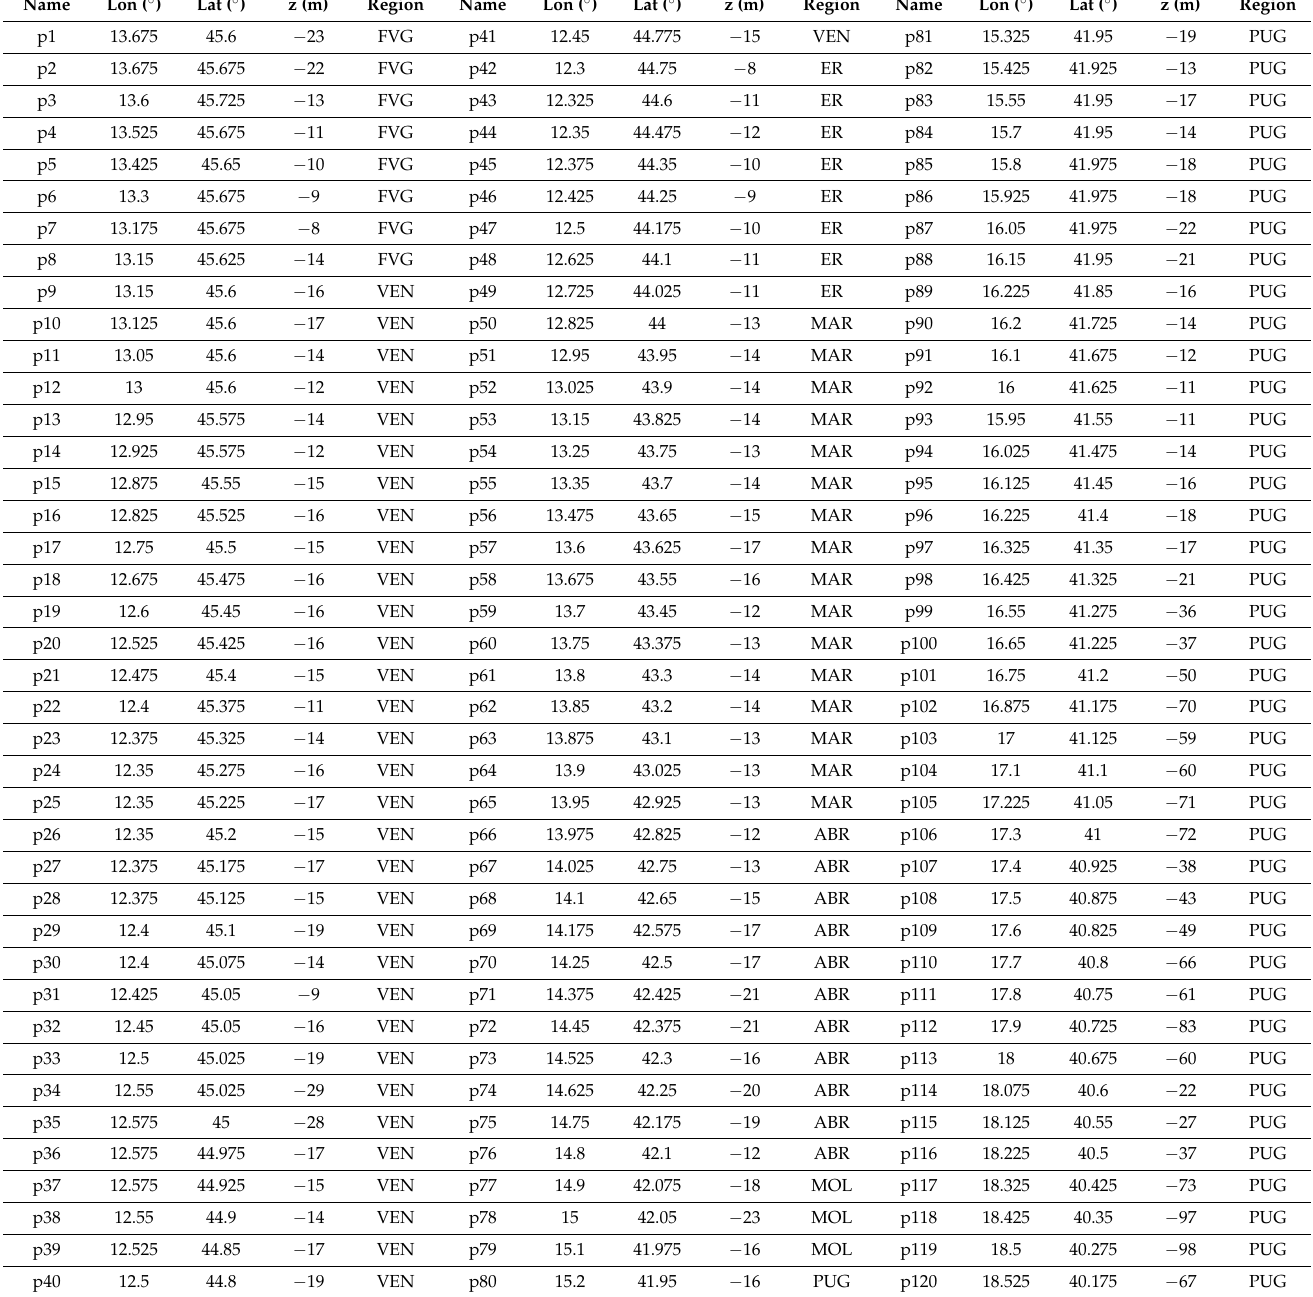
Table 1. Name, locations, depth and corresponding administrative Italian region of the 120 points (or virtual wave buoys) along the Adriatic coast where the wave characteristics are